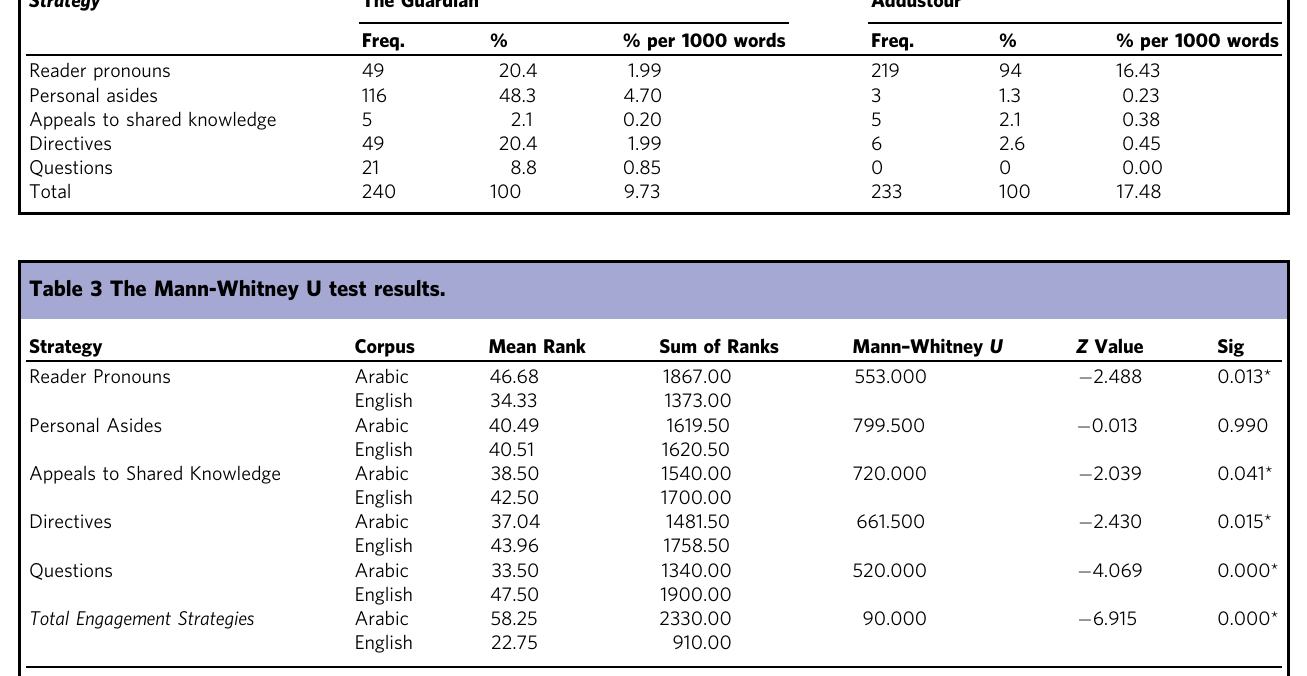
Table 2 Frequencies, percentages, and frequencies per 1000 words of the two corpora. Strategy